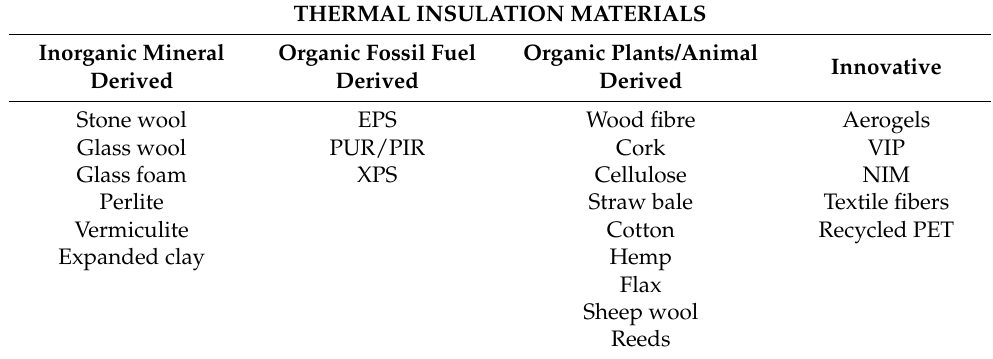
Table 1. Some types of materials for thermal insulation of